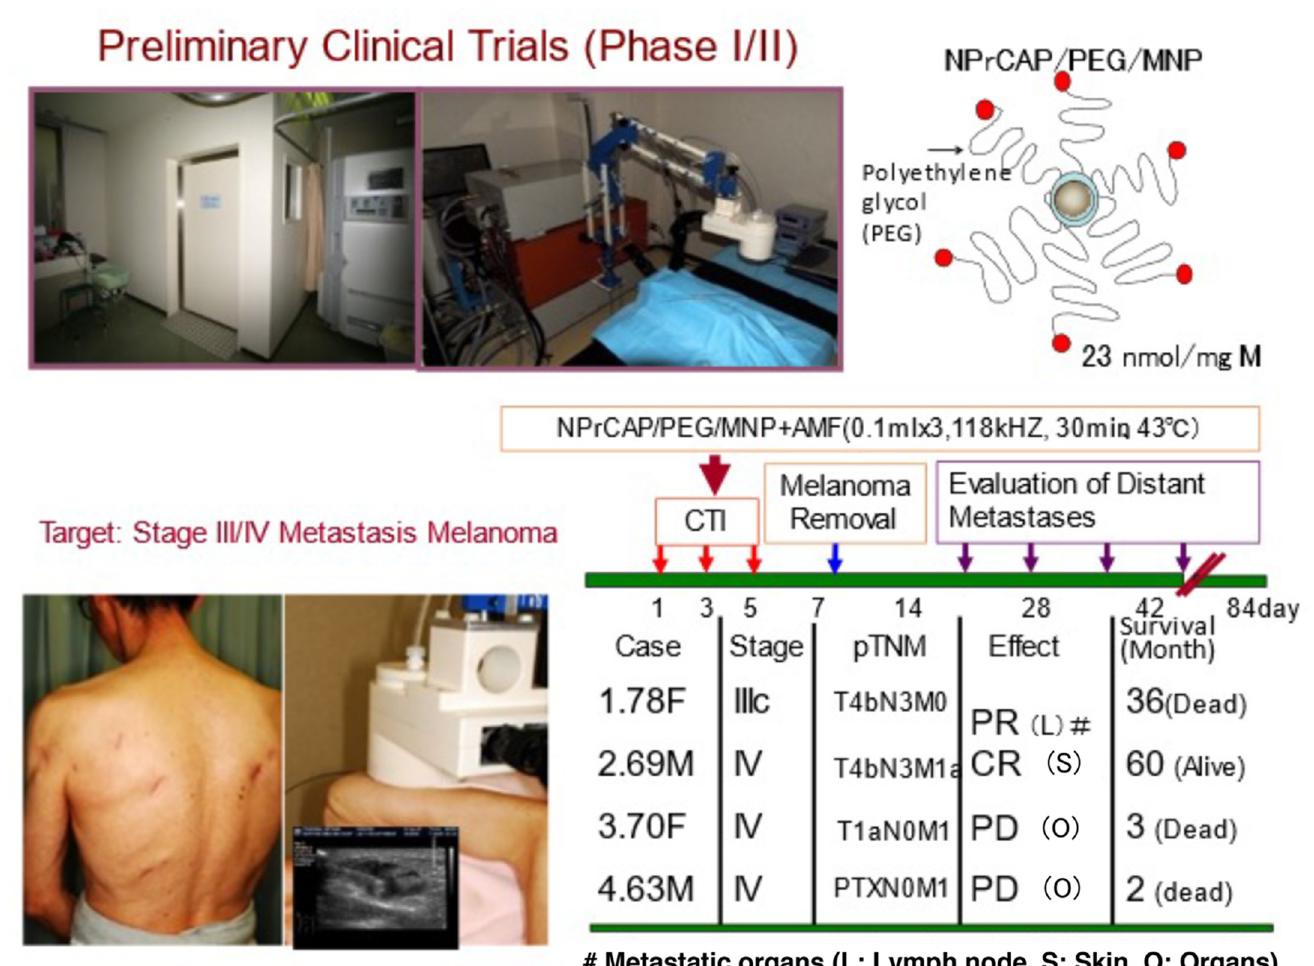
Figure 17. Preliminary clinical trials of CTI therapy for advanced metastatic melanoma patients in stages III and IV. Upper photos show the treatment room ( left ) and medical device for AMF exposure ( right ) for CTI therapy. The black and white ultrasound insert in the lower photo shows the drug is being given into the metastatic lymph node through an ultrasound-guided needle. # shows metastatic organs. PR: partial response, CR: complete response, PD: progressive disease.